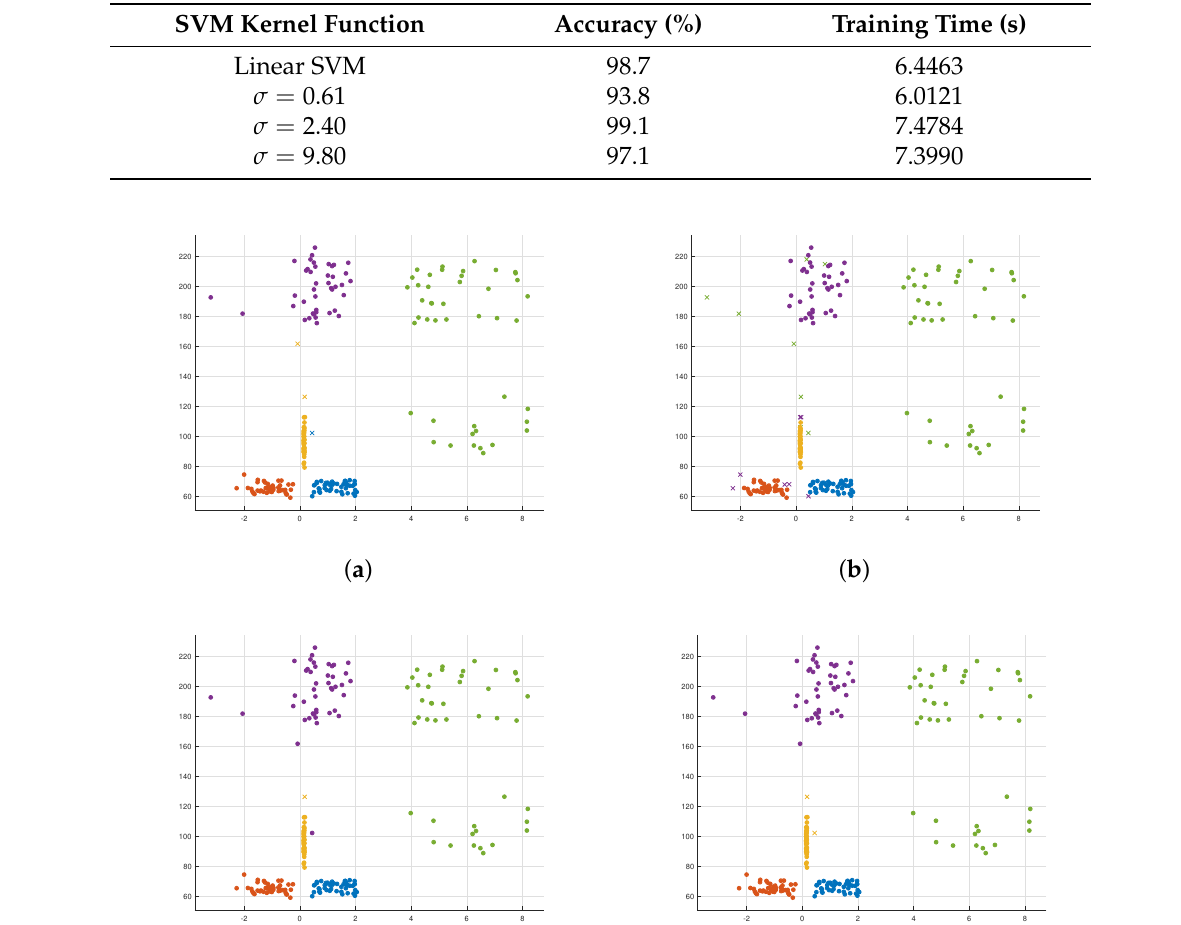
Table 3. Classification comparison in SVM with Different Kernel Scale.